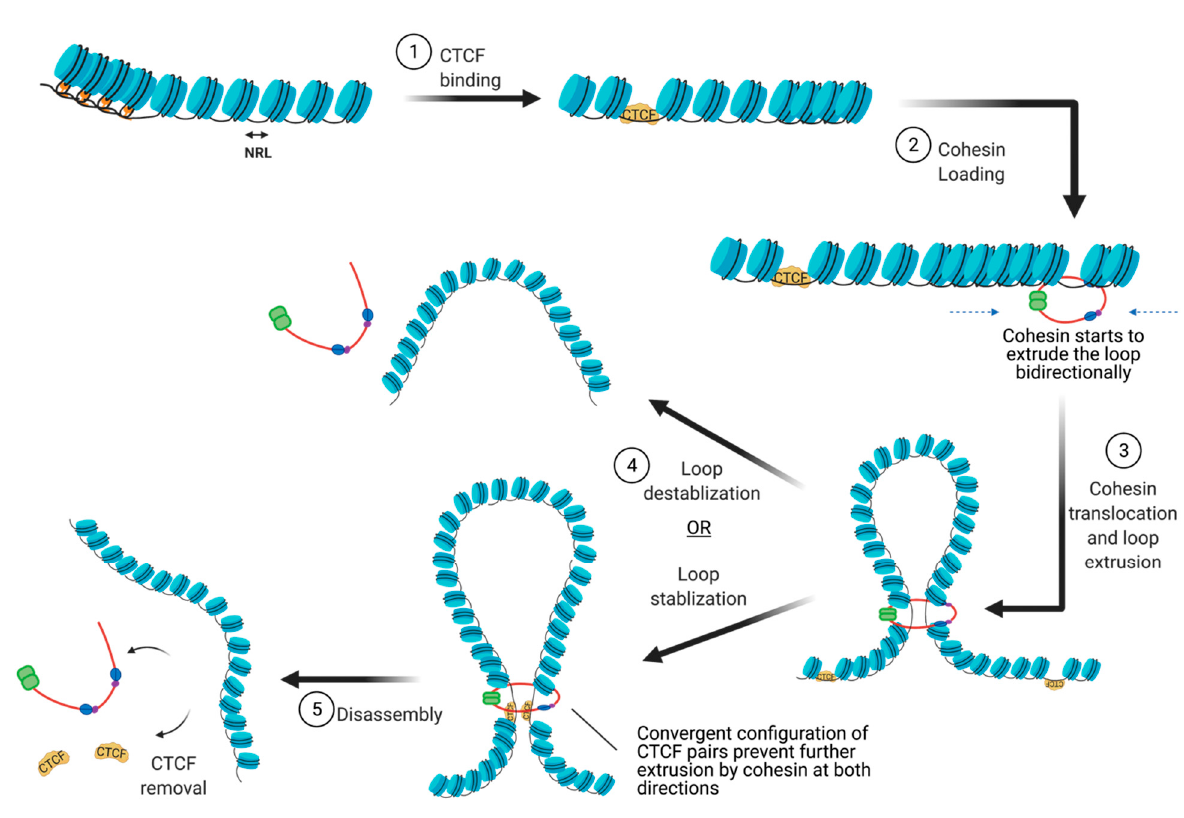
Figure 3. The steps involved in the establishment of CTCF/cohesin mediated looping interactions. (abb: NRL: Nucleosome repeat length).